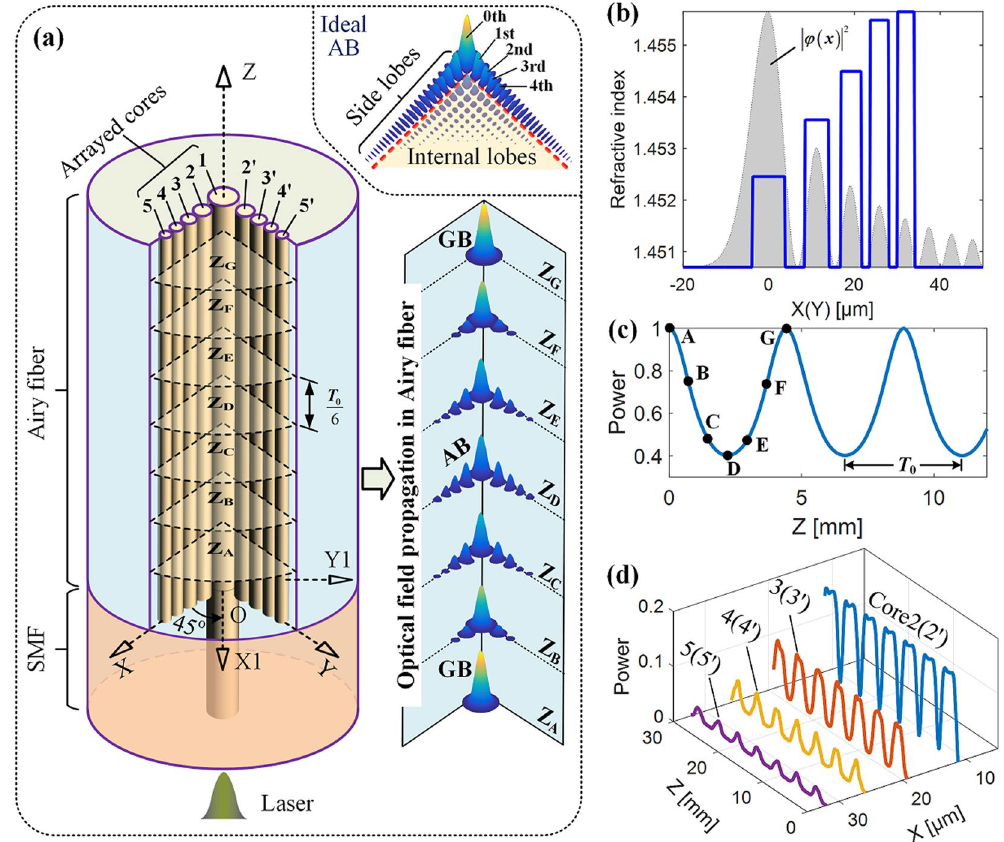
Figure 1. Wave propagation in an Airy fiber. ( a ) Working principle (left) and the transverse fields propagation in the fiber (right). The inset is corresponding the ideal Airy beam. ( b ) The RI profile (solid line). The shaded area in ( b ) depicts the Airy intensity pattern. ( c and d ) are normalized power curves as a function of fiber length in the center main core and side cores,